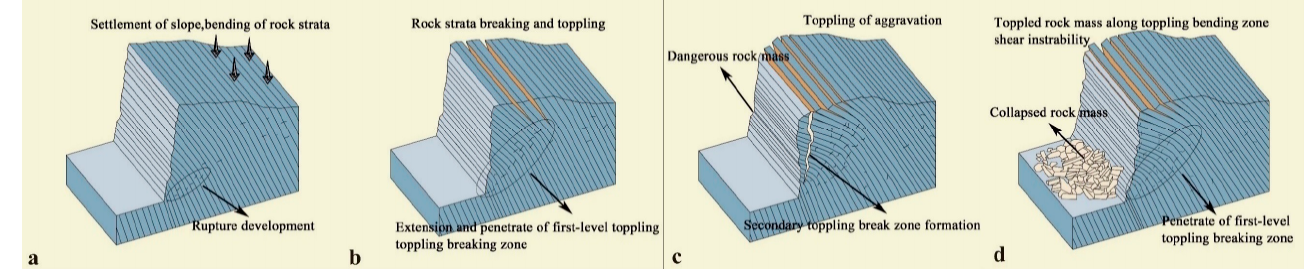
Figure 14. “Toppling-collapse” disaster pattern. ( a ) settlement of slope bending of rock strata, ( b ) first-level toppling breaking zone, ( c ) second-level toppling breaking zone, ( d ) toppled rock mass.